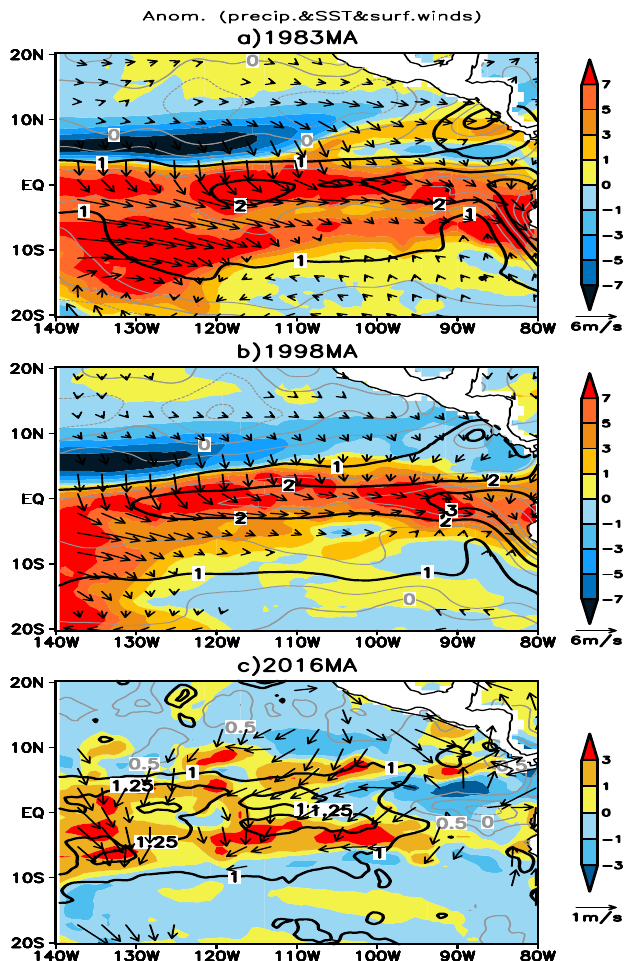
Figure 5. Spatial pattern of the anomalies of precipitation (color shaded; mm/day), SST (contours; °C), and surface winds (vectors; m/s; wind speed smaller than 0.5 m/s has been masked out) over the tropical eastern Pacific (140° W–80° W, 20° S–20° N) in March–April for ( a ) 1983, ( b ) 1998 and ( c ) 2016.